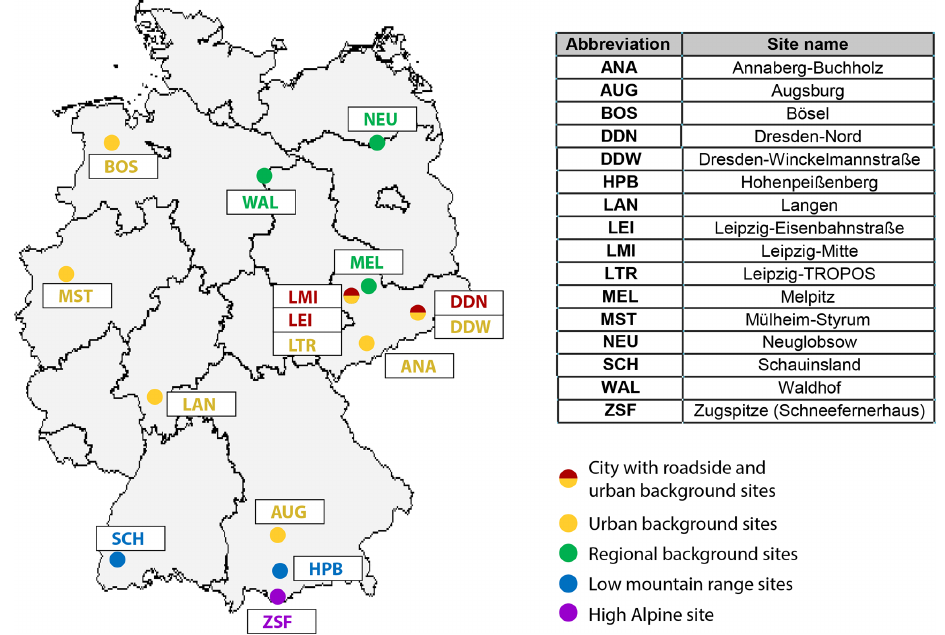
Figure 1. Map of the 16 atmospheric measurement stations in the